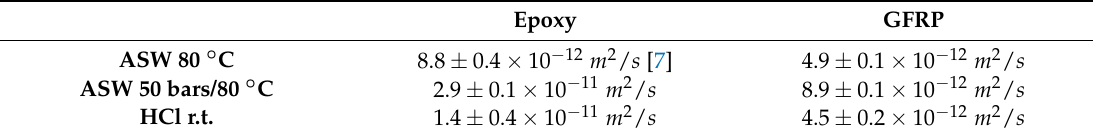
Table 2. Diffusion coefficients calculated from Figure 4. ASW = artificial sea water.